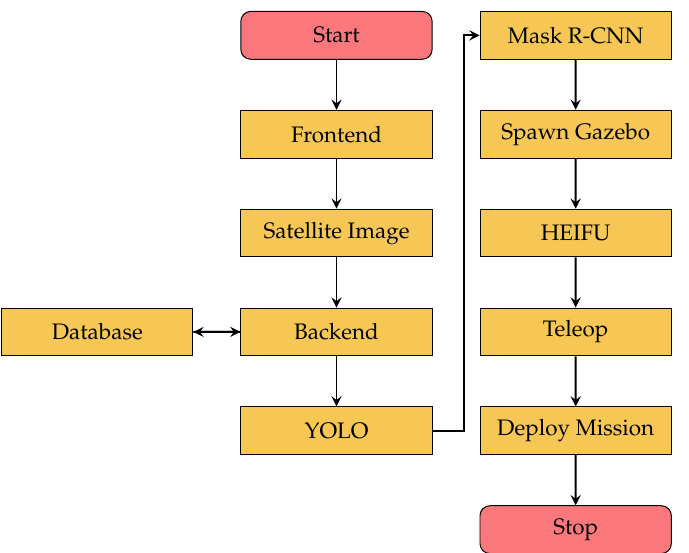
Figure 1. Leaflet to Gazebo Pipeline